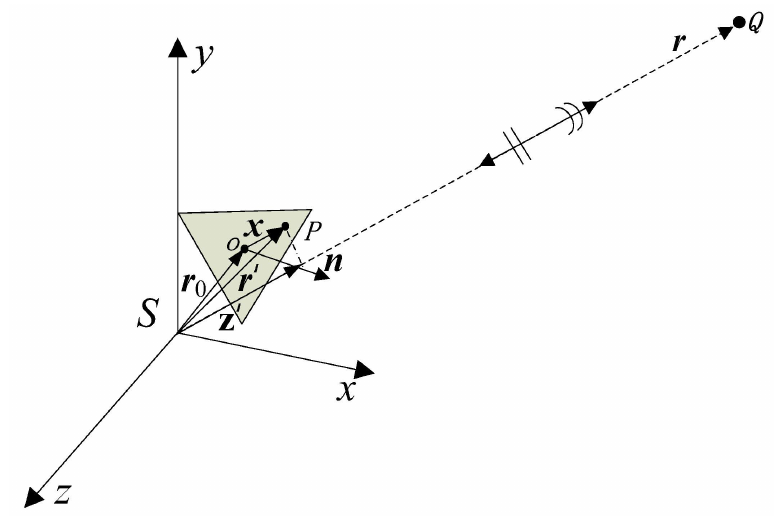
Figure 1. Time domain discrete integral acceleration algorithm